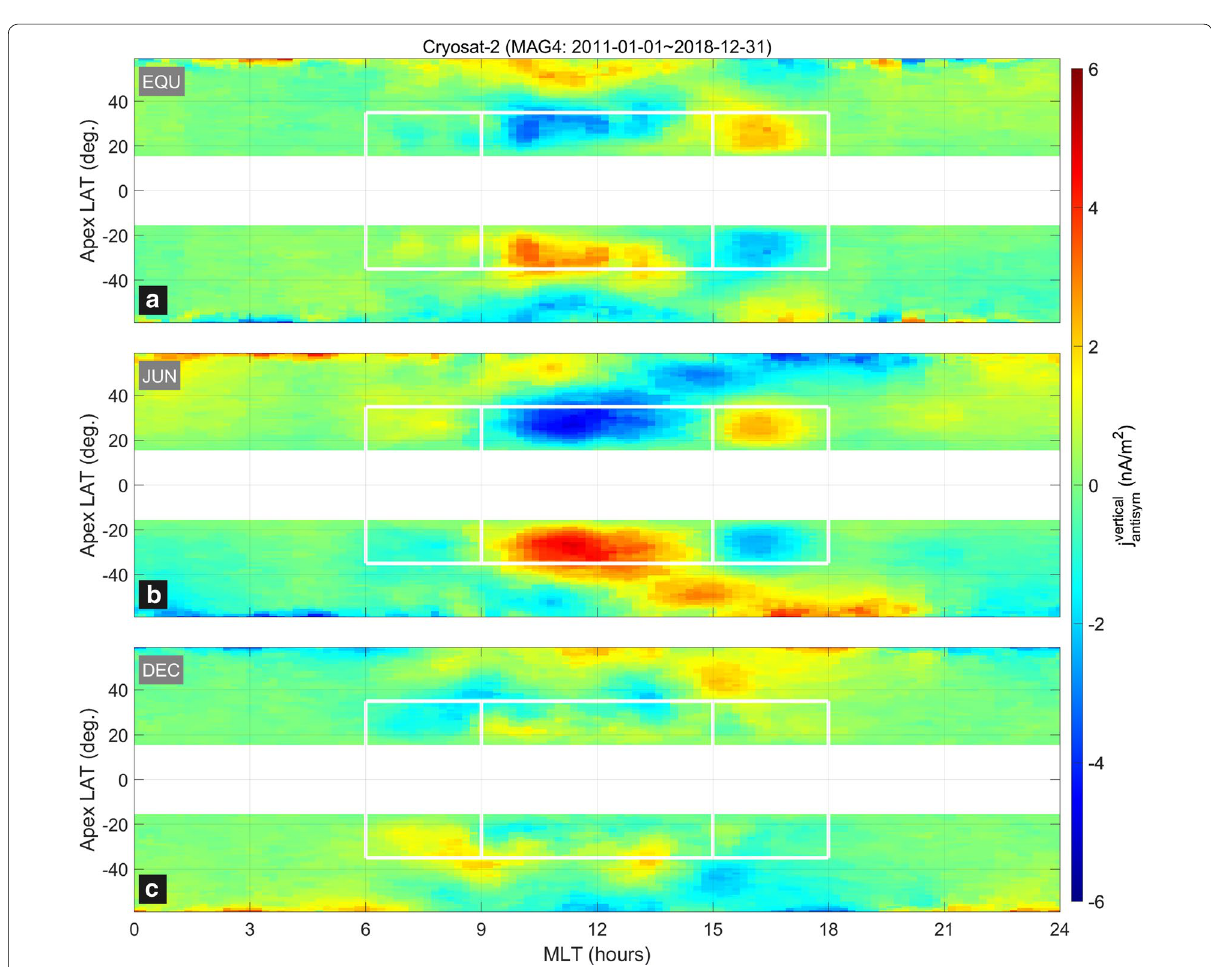
Fig. 6 The same as Fig. 2, but the vertical axis represents apex latitudes mapped along background magnetic field lines down to 110